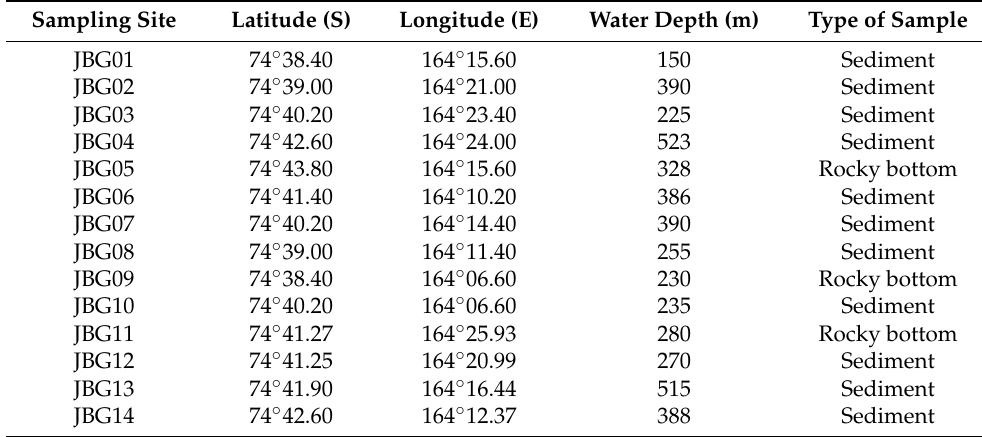
Table 1. Sampling location and type of samples collected from Terra Nova Bay, Ross Sea,